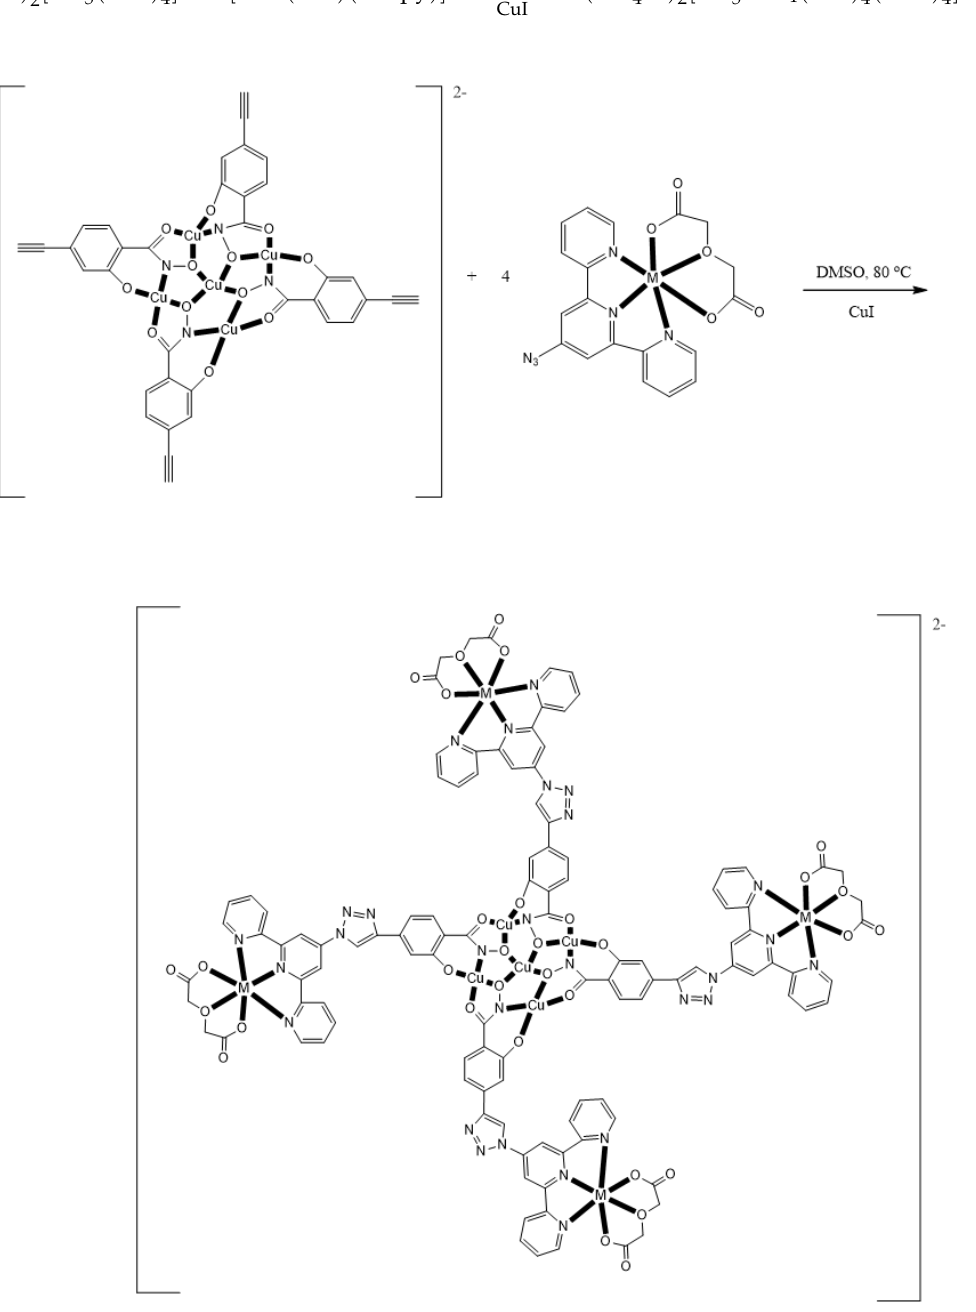
Figure 16. Representation of the CuAAC click reaction between 25 and 26 / 26a that leads to the enneanuclear 3d/3d’ heterometallic clusters 27 / 27a . The cations Me 4 N + are not shown. The 3d / 3d’ heterometallic clusters 27 / 27a . The cations Me 4 N + are not shown. The coordination bonds are drawn coordination bonds are drawn with bold lines. M = Co, Zn. with bold lines. M = Co,